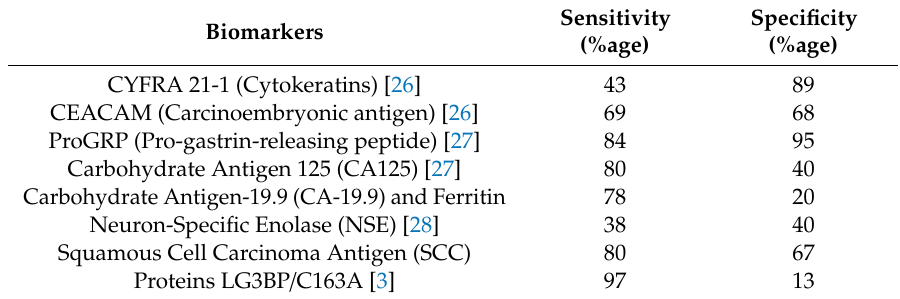
Table 4. Important clinical biomarkers with sensitivity and specificity for the presence of cancer.